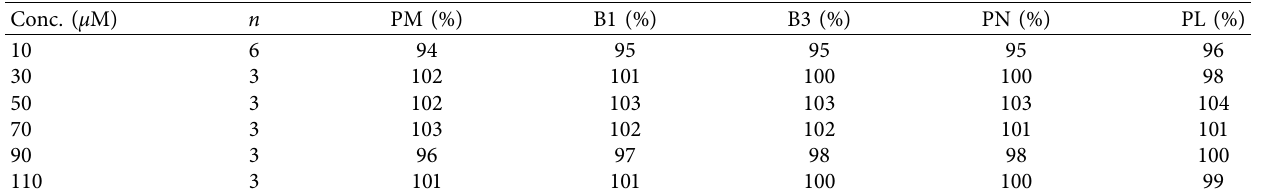
Table 2: Method accuracy expressed as percentage recovery.